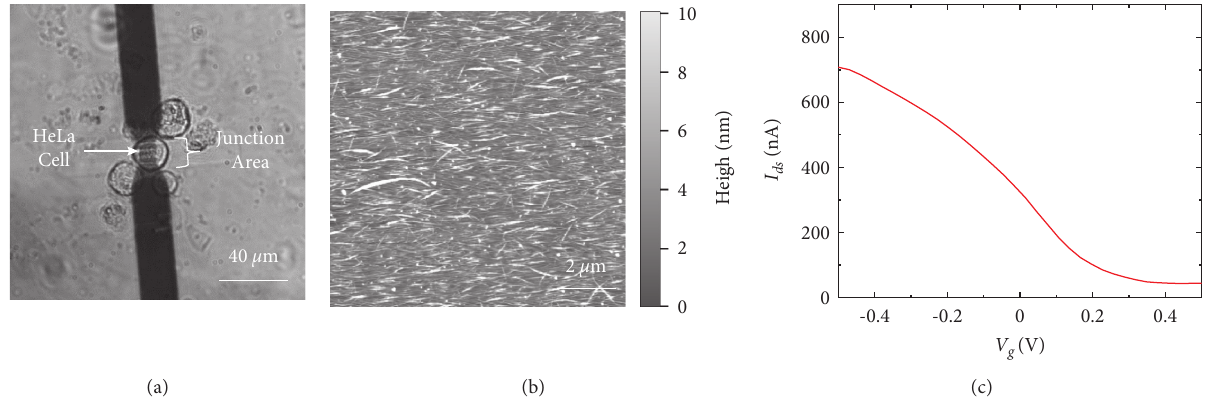
Figure 2: Basic characteristics of a SCN device. (a) Optical image showing a HeLa cell placed on a SCN device with three floating electrodes. (b) AFM topography image of the exposed area of a SCN device with aligned CNTs. (c) Liquid gating effect of a SCN device showing the decrease of a drain-source current I ds along with the increase of a gate bias V g